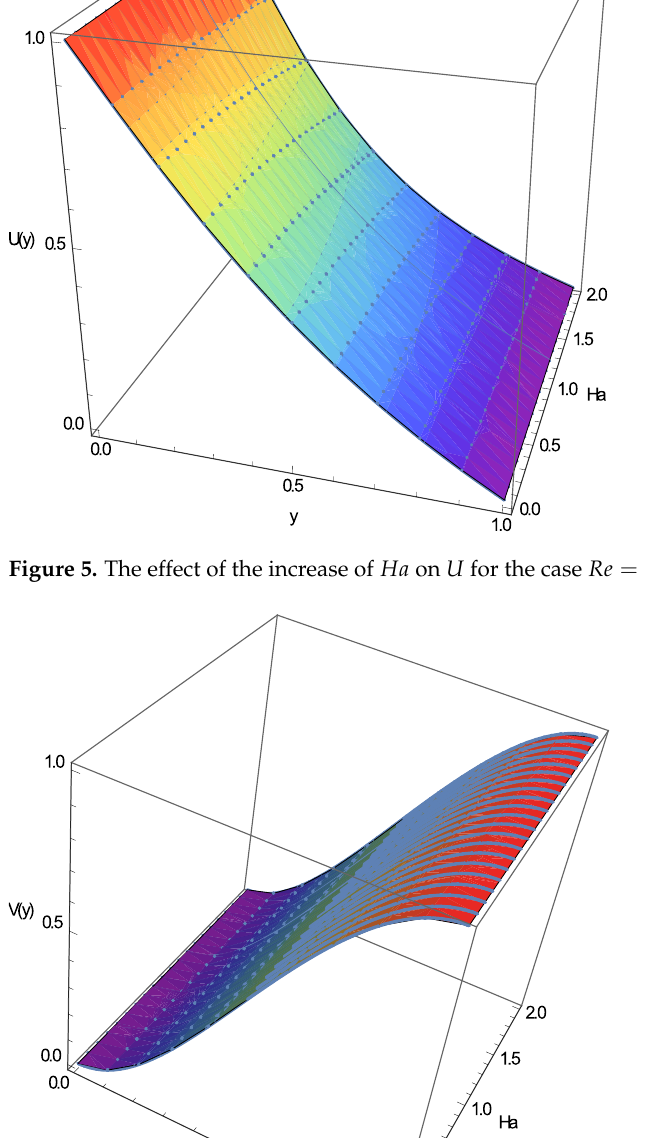
and V ( y ) , impact highlighted in the Figures 7 and 8 for y = 0.2 (red surface), y = 0.4 (blue surface), y = 0.6 (yellow surface) and y = 0.8 (green